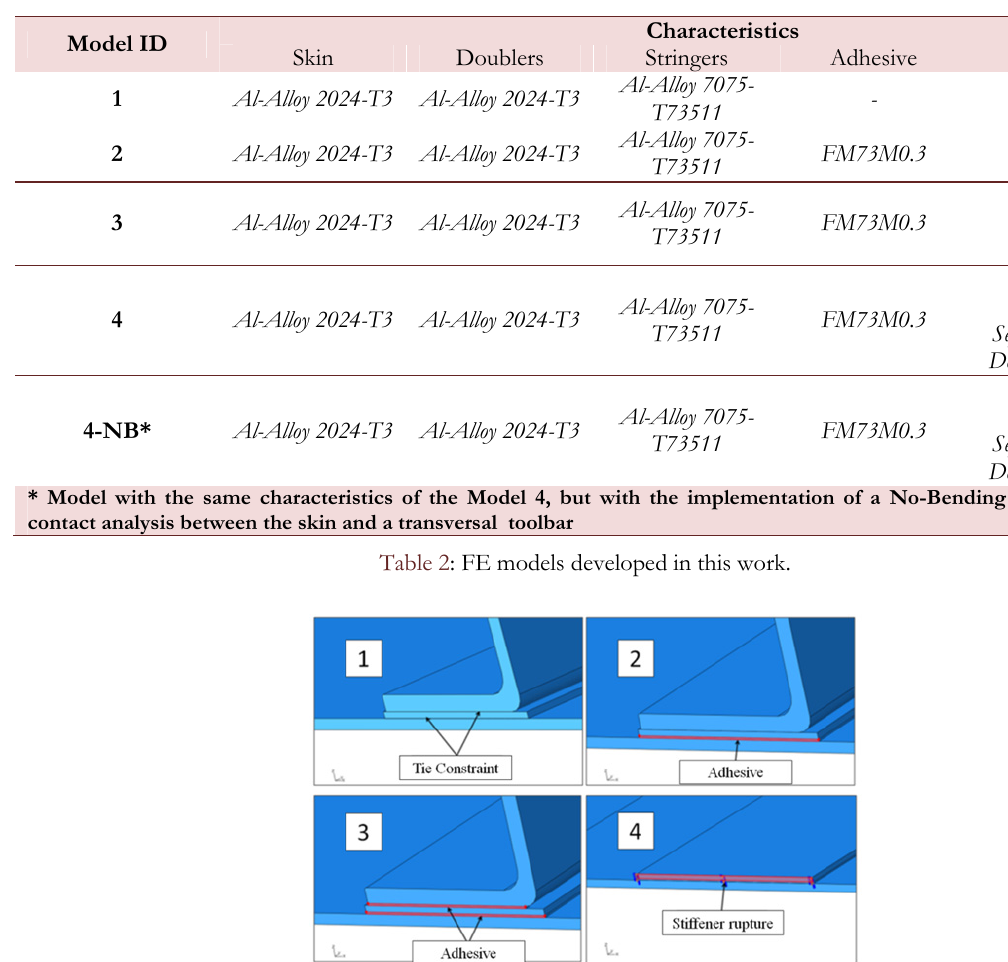
Figure 13: Representation of the different skin-stiffener couplings